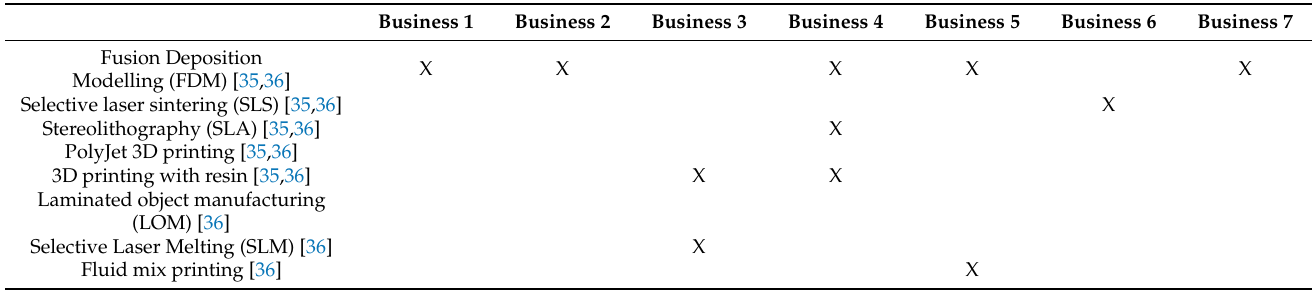
Table 2. 3D printing technologies